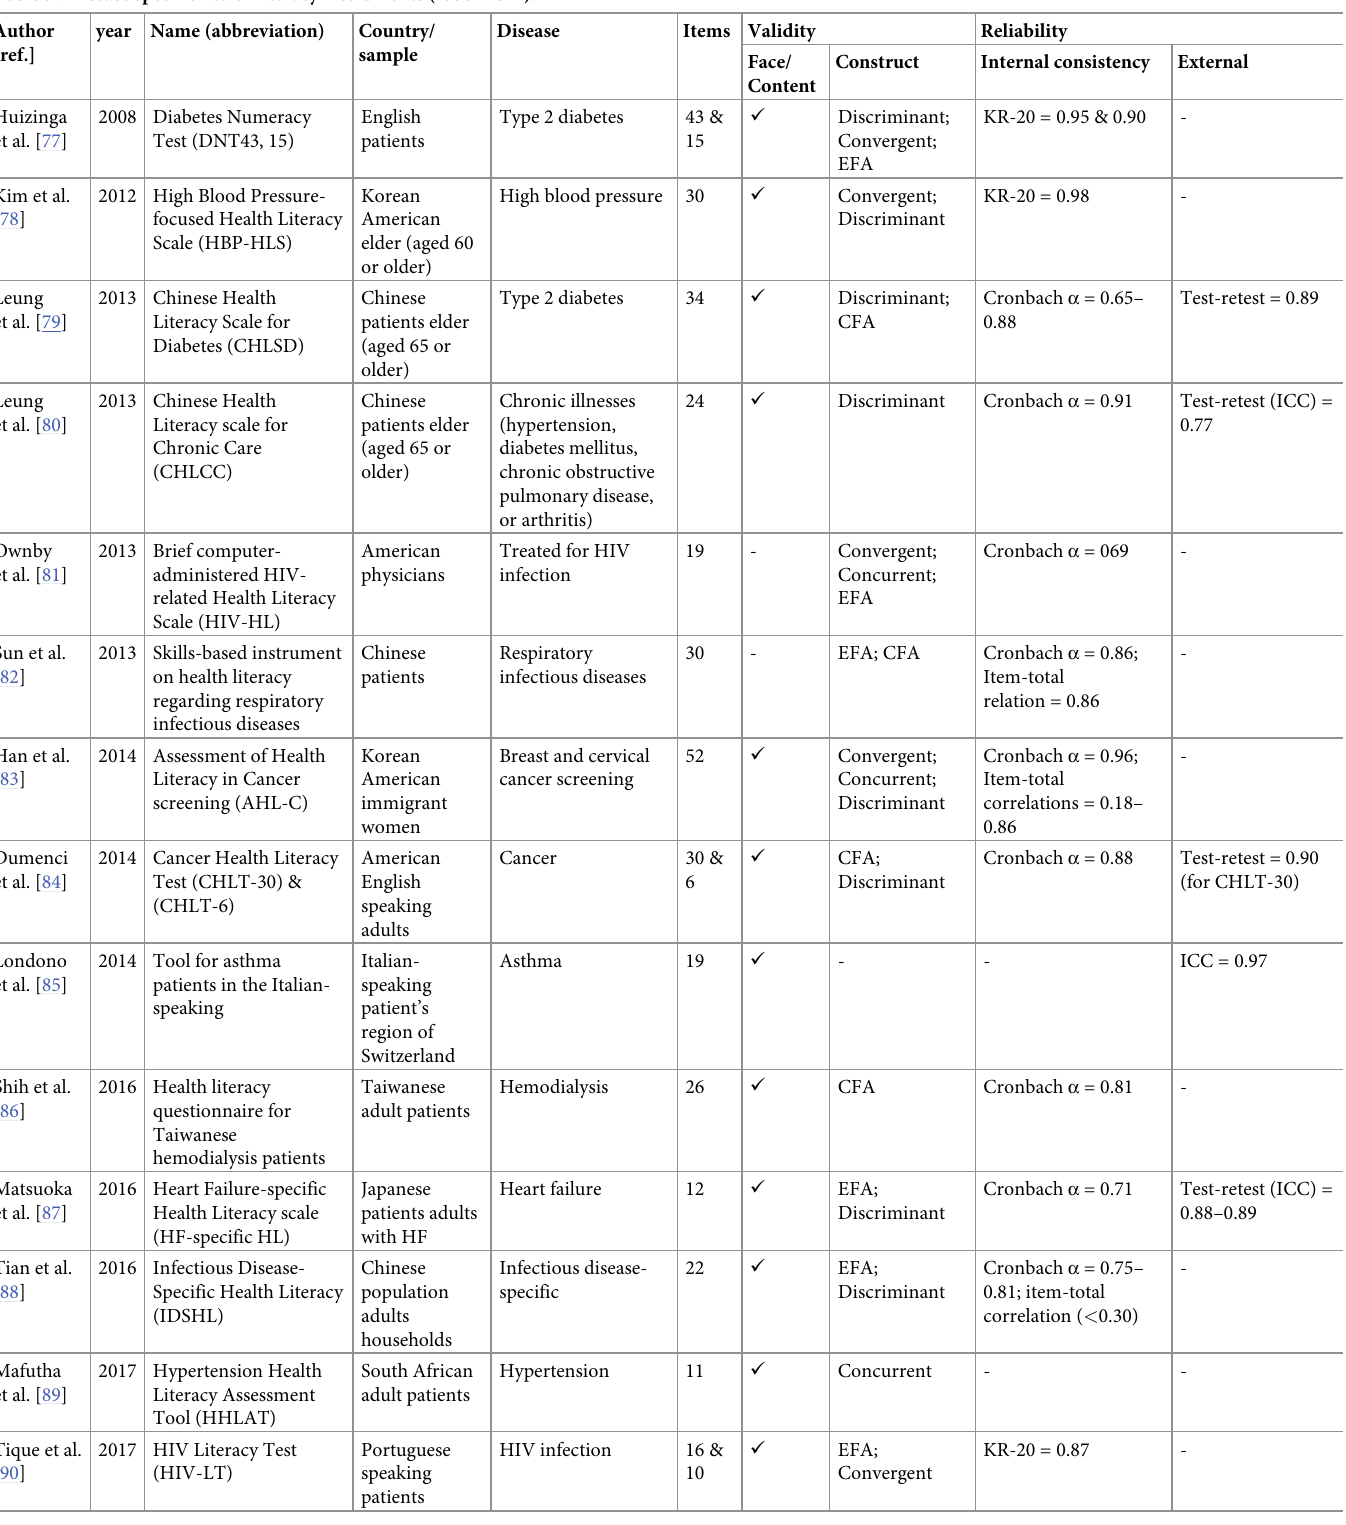
Table 3. Disease specific health literacy instruments